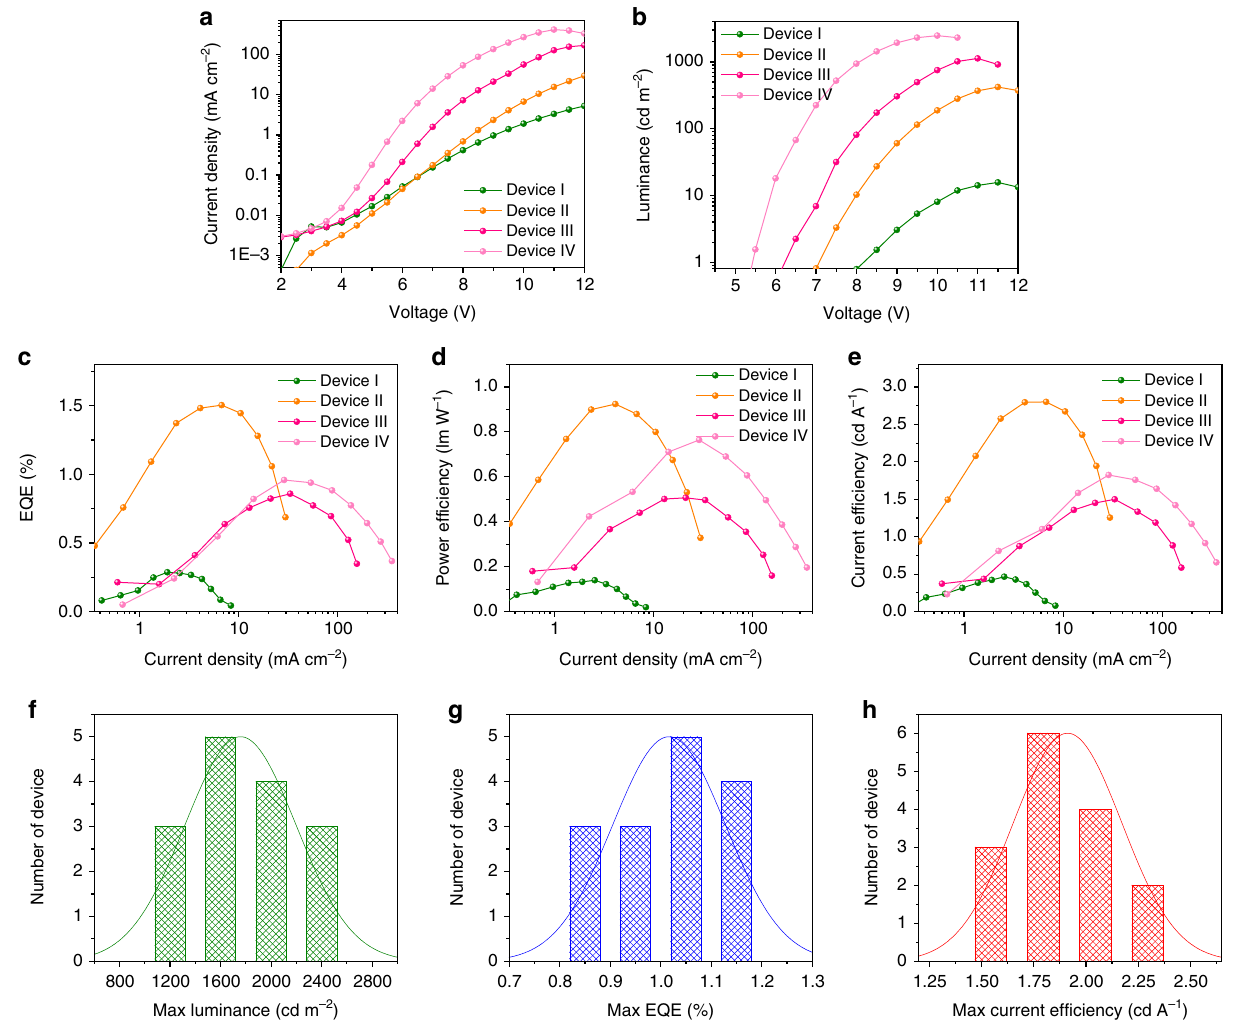
Fig. 4 EL performance of PeLEDs. a Current density-voltage, b luminance-voltage, c EQE-current density, d power ef fi ciency-voltage and e current ef fi ciency-voltage characteristics of PeLEDs made from perovskite fi lms with different thickness: Device I (125 nm), Device II (80 nm), Device III (60 nm), and Device IV (40 nm). f − h Histogram of maximum luminance, EQEs, current ef fi ciency for 15 Devices IV from four batches. Average luminance of 1758 cd m − 2 with a relative standard deviation of 22%, average EQE of 1.0% with a relative standard deviation of 11% and average current ef fi ciency of 1.9 cd A − 1 with a relative standard deviation of